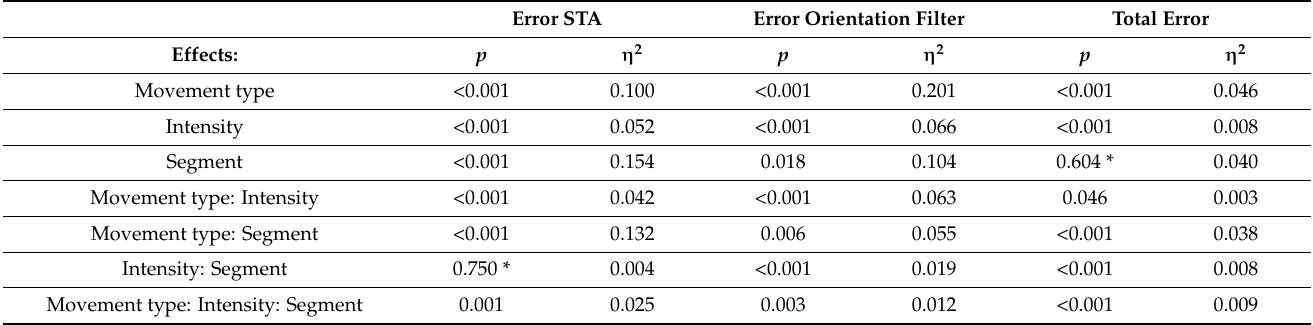
Table 2. Significance and effect size of main and interaction effect of movement type, intensity, and segment on the root-mean-square difference of the error caused by the soft tissue artefact (STA), the orientation filter, and the total error. Insignificant effects were denoted with an asterisk (*). Error